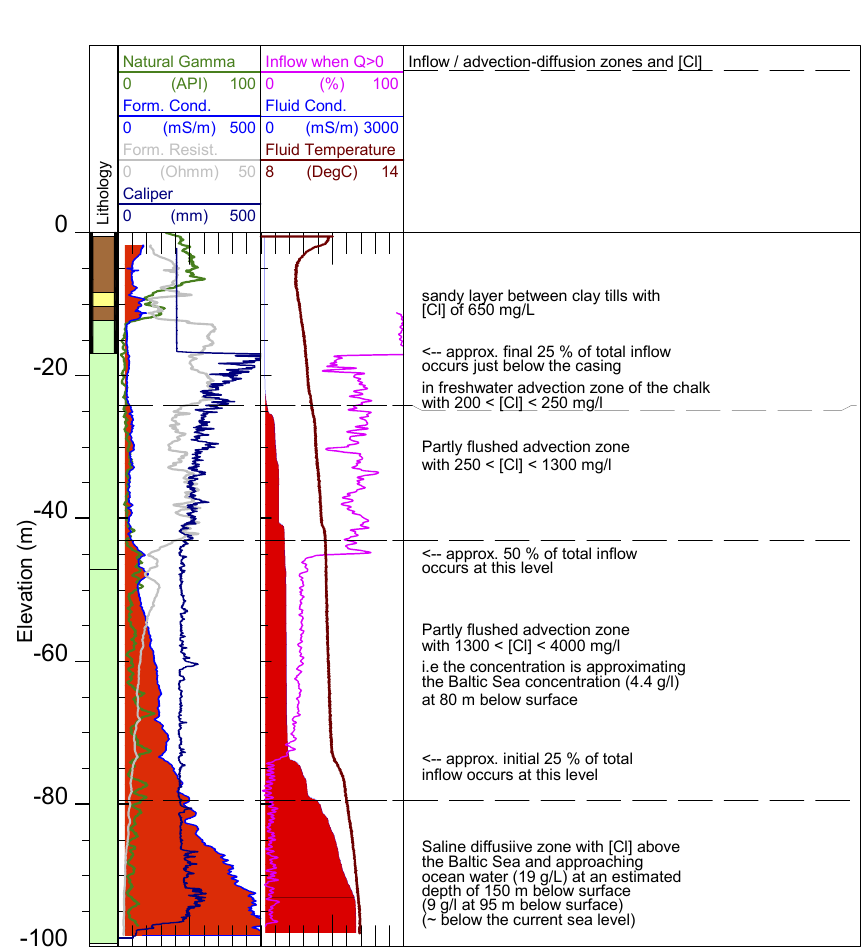
Fig. 10. Results of geophysical borehole logs from the new deep investigation well (Well no. 242.344, Figs. 2 and 9).